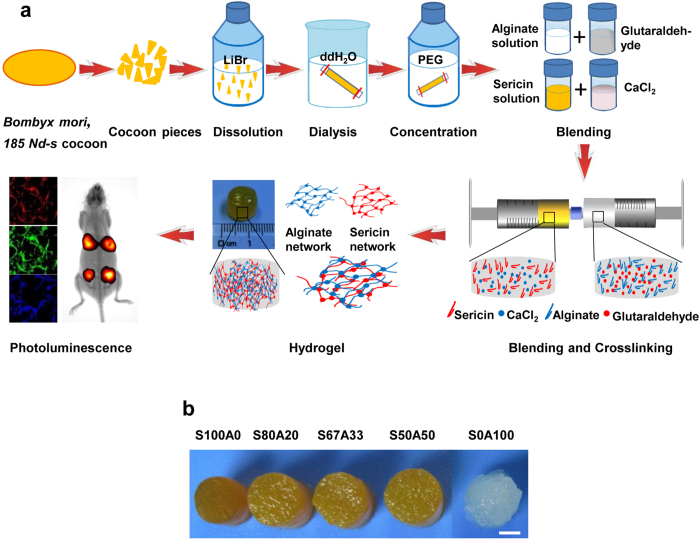
Schematics describing a strategy of fabricating the sericin-alginate hydrogels with double interpenetrating networks and the images of these IPN hydrogel samples.(a) A flow chart shows the procedure of sericin extraction, and the fabrication and bioimaging of an IPN hydrogel with the double networks. (b) Photographs of the sericin-alginate IPN hydrogels fabricated using different sericin-to-alginate ratios (v/v). Scale bar, 5 mm.